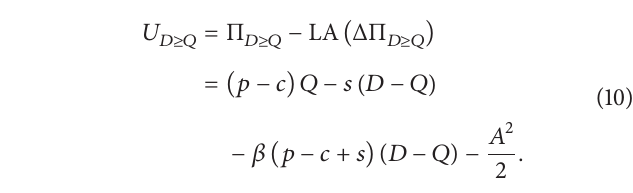
Figure 3: Surplus and stockout loss aversion function when Π 0 = Π max